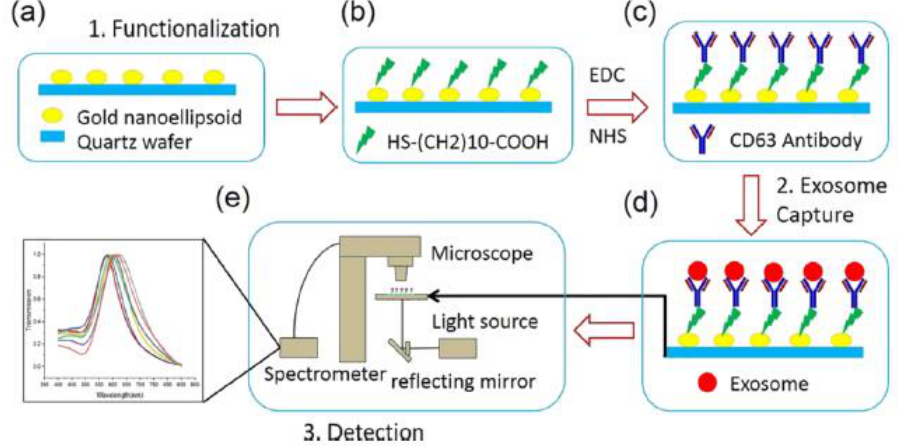
Figure 22. Schematic of the LSPR-based biosensor for the detection of the exosomes. ( a ) Fabricated gold nano-ellipsoid arrays on the quartz substrate. ( b ) Functionalization of the gold nano-ellipsoids with the Au – S bond. ( c ) Functionalization of anti-CD63 antibody ( d ) Exosomes injected into the microchannel and captured on the sensor substrate. ( e ) LSPR detecting platform (Reproduced with permission from Xiaoqing Lv et al. [88]. Copyright 2019, American Chemical Society).